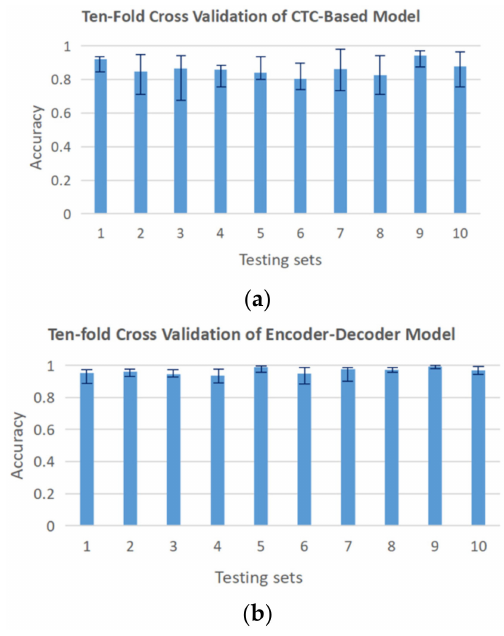
Figure 14. Ten-fold cross-validation of sequence recognition models: ( a ) CTC-based model; ( b ) encoder-decoder